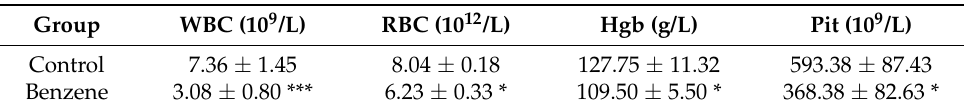
Table 2. Effects of benzene on blood routine. WBC: white blood cell; RBC: red blood cell; Hgb: hemoglobin; Pit: platelet.